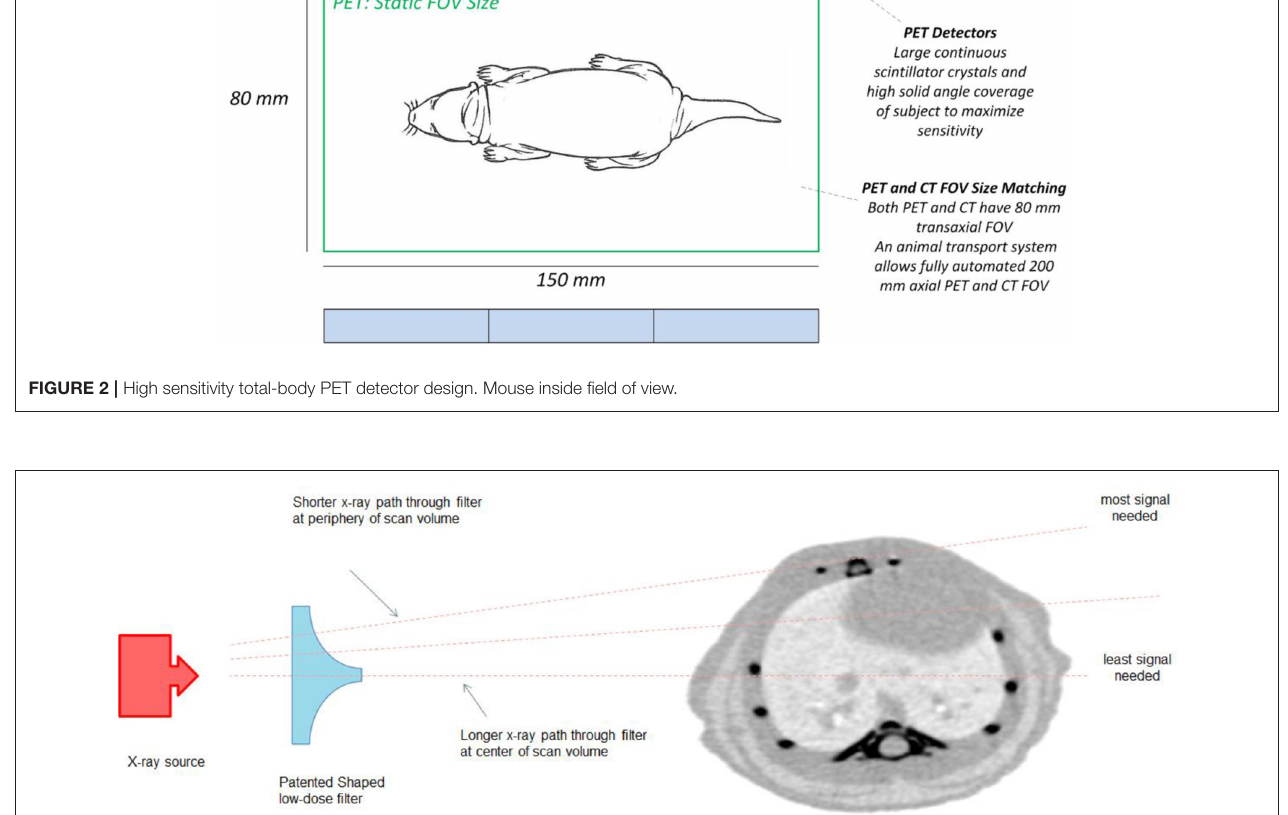
FIGURE 3 | Novel X-ray beam shaper for low-dose imaging.